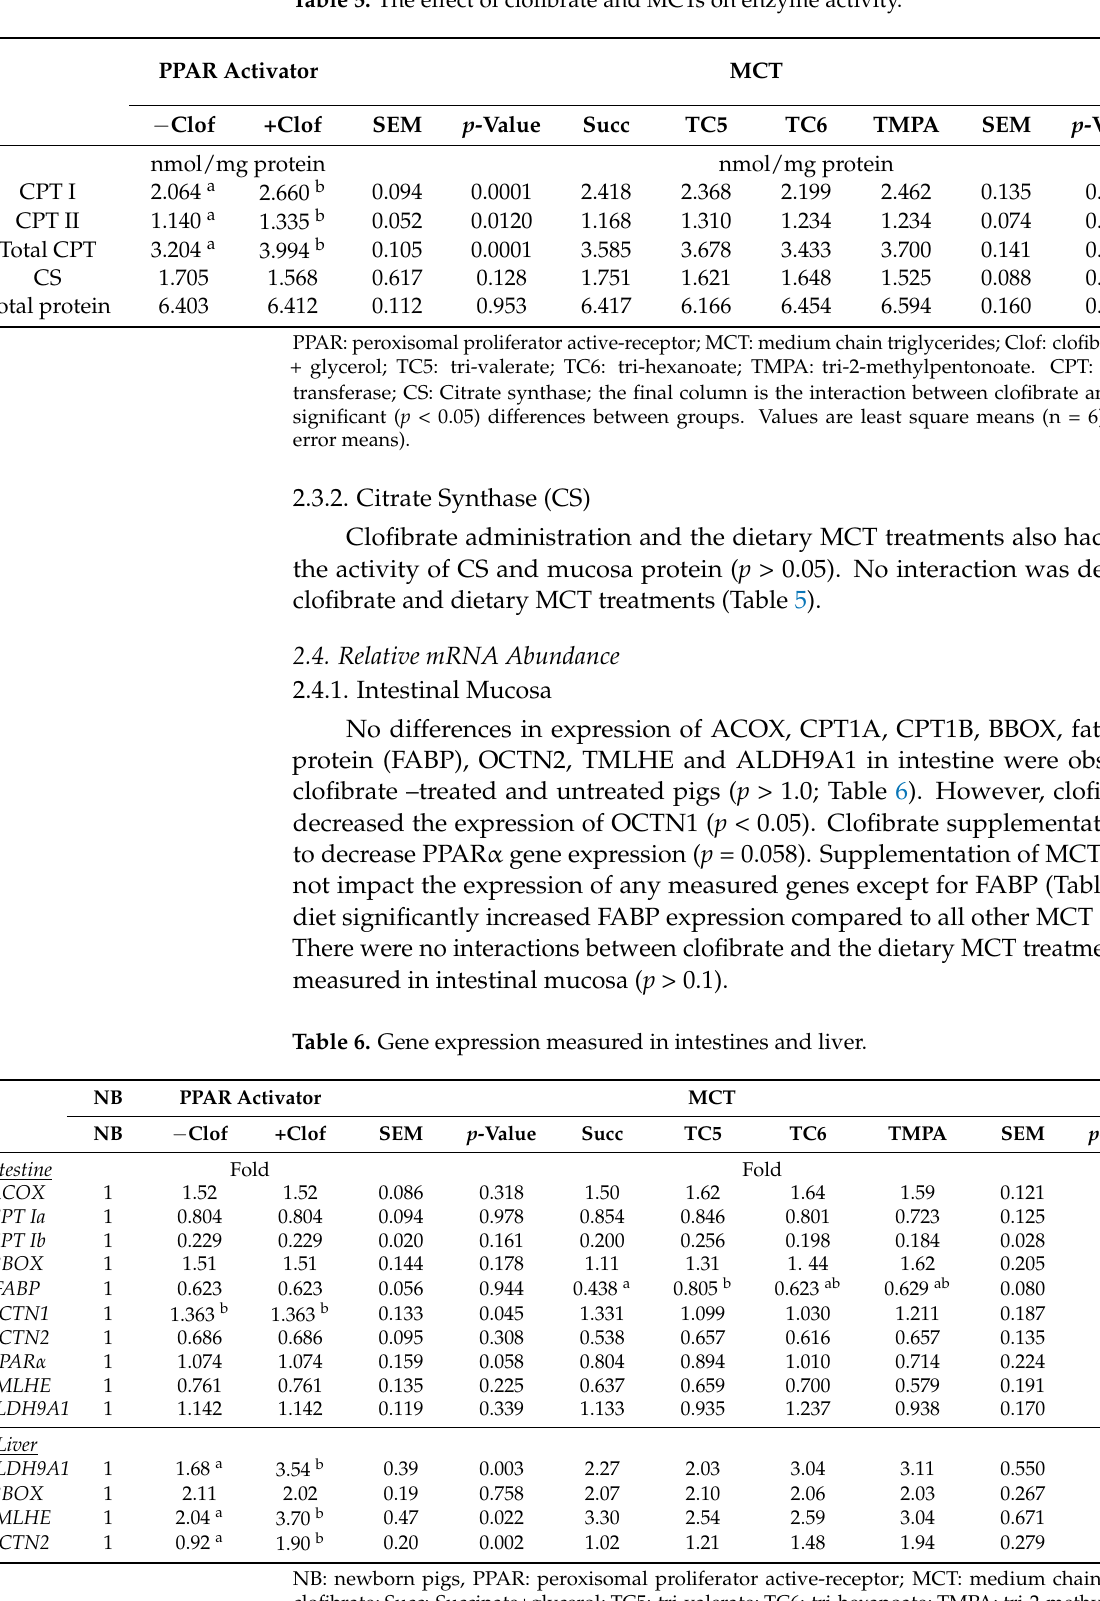
Table 5. The effect of clofibrate and MCTs on enzyme activity.